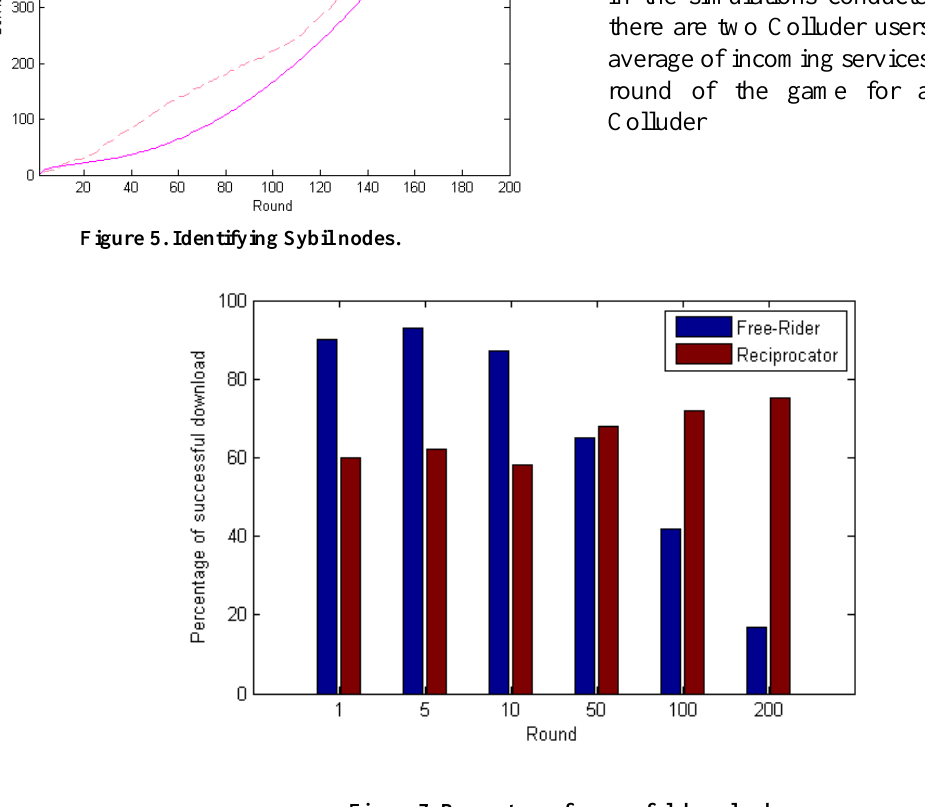
Figure 7. Percentage of successful